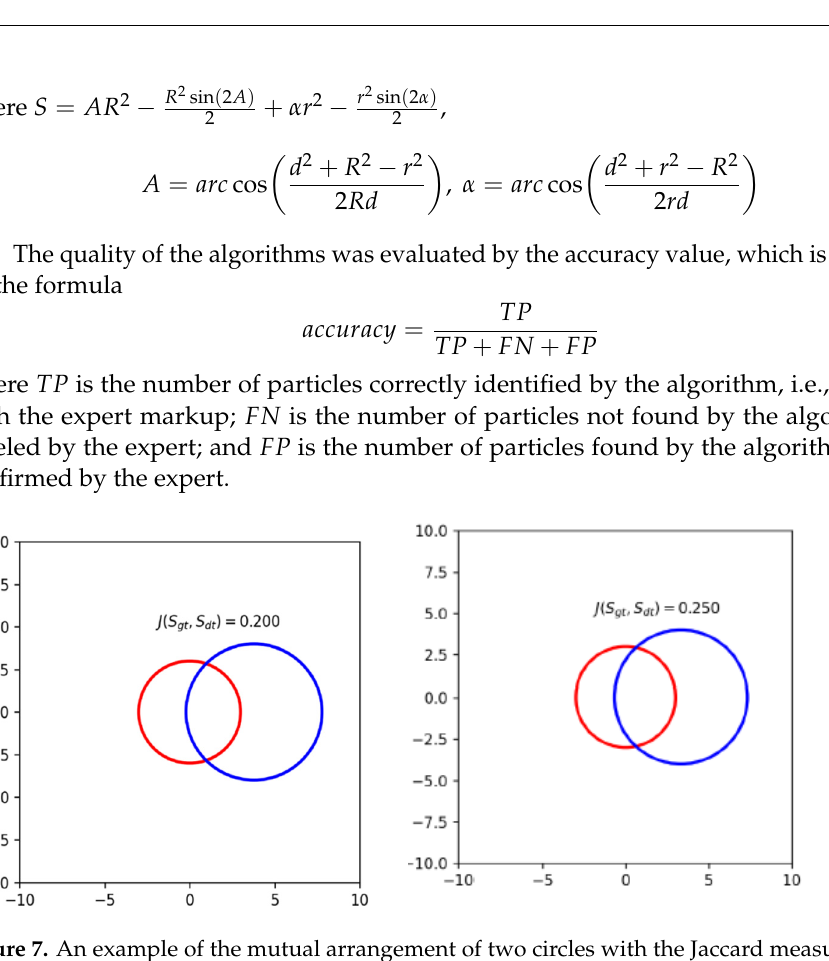
Figure 7. An example of the mutual arrangement of two circles with the Jaccard measure equal to 0.20 and 0.25.